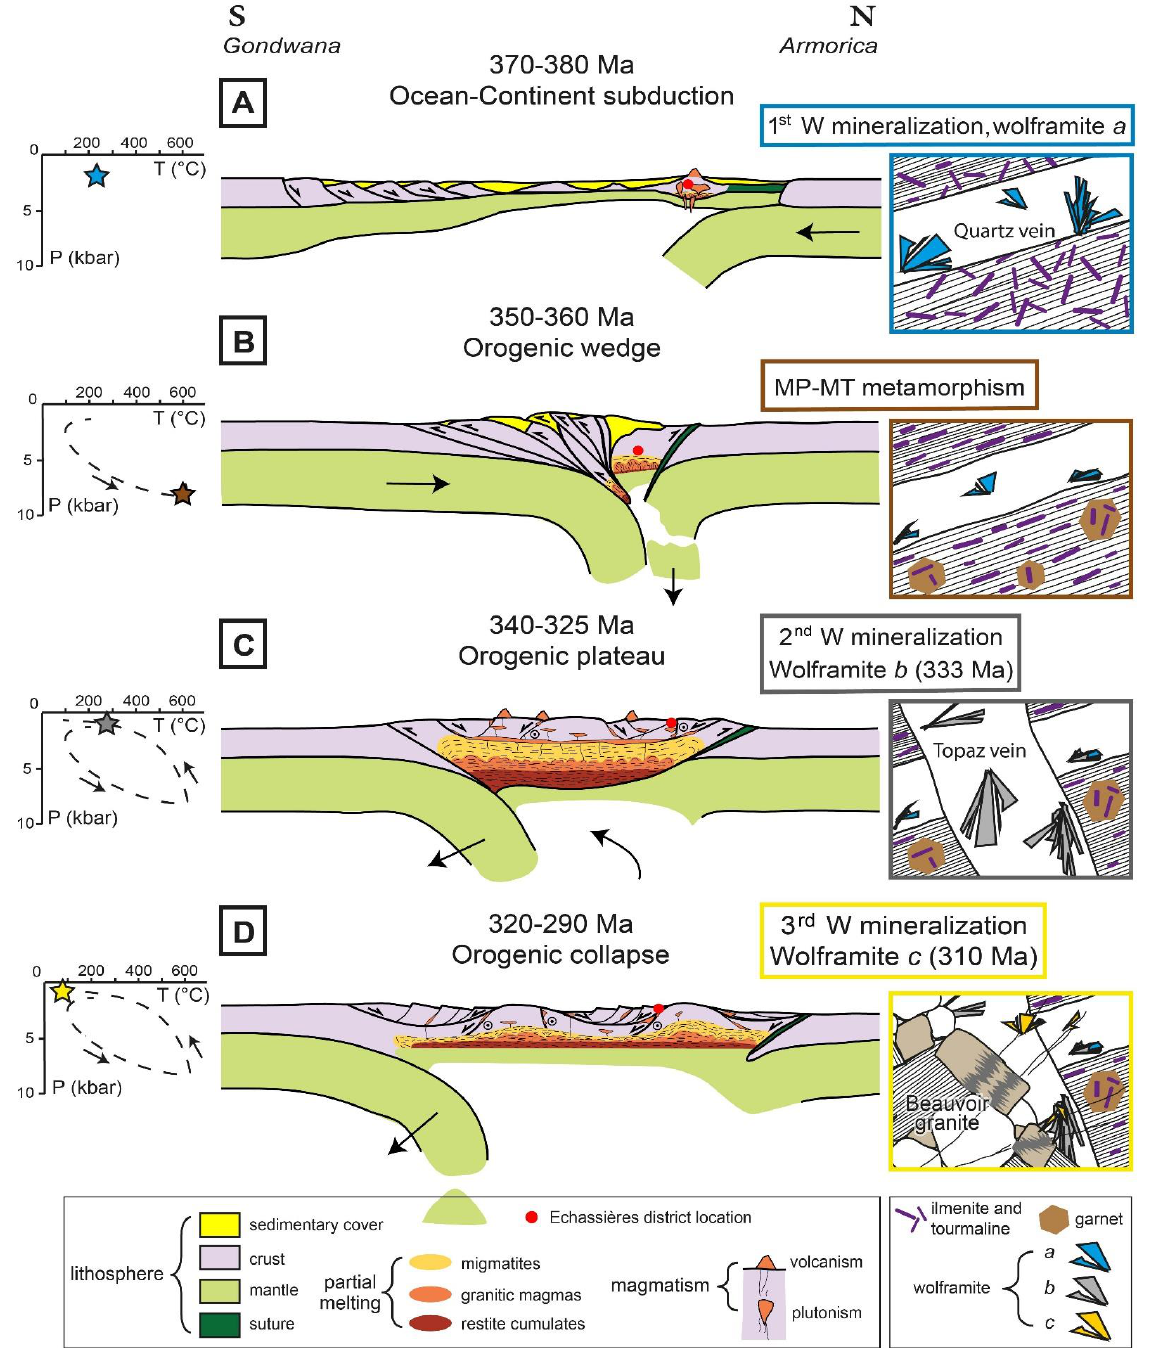
Figure 6. Geodynamic settings and associated petrographic evidences for multiple W mineralizations in the Echassières district. PT-path is constrained by metamorphic assemblages [23,36], fluid inclusion microthermotetric data from [35], and compilation of geochronological data compiled in the Figure 5. ( A ) Ocean-Continent subduction. ( B ) Orogenic wedge. ( C ) Orogenic plateau. ( D ) Orogenic collapse.